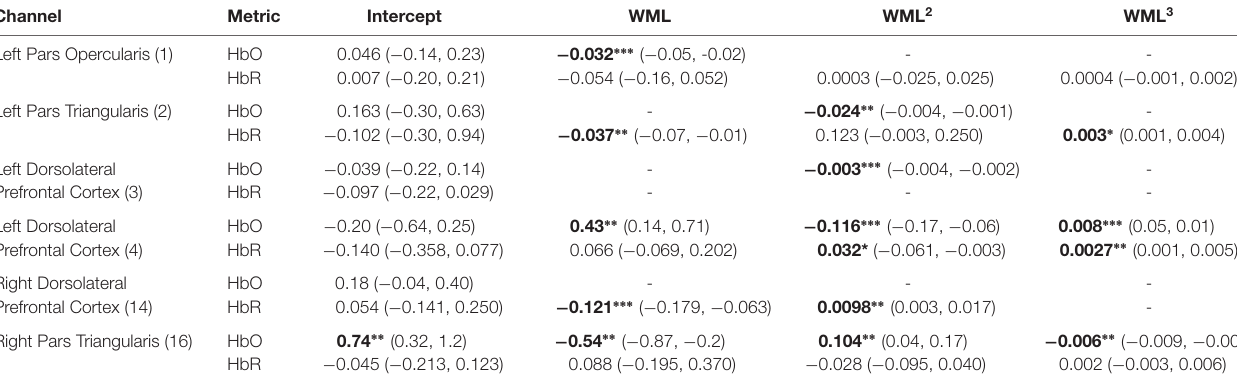
TABLE 1 | Effects of working memory load on relative concentrations of oxygenated hemoglobin (HbO) frontal cortex for the most parsimonious model. Channel Metric Intercept WML WML 2 WML 3